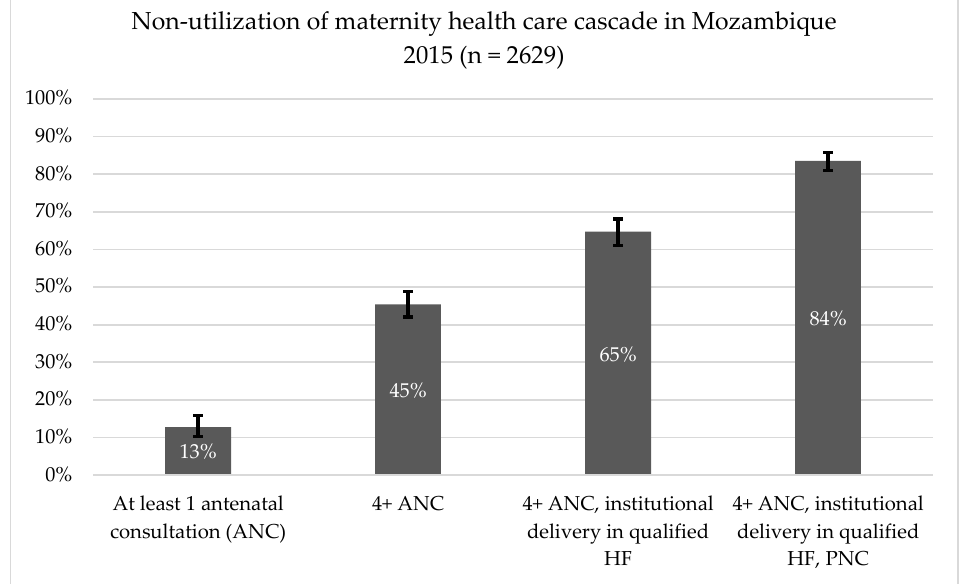
Figure 1. Levels of non-utilization of select maternity health care cascade components among women respondents ( n = 2629) of the 2015 national health survey, Mozambique. Notes: ANC − ante natal consultation, HF − health facility; PNC − postpartum (post-natal) consultation.